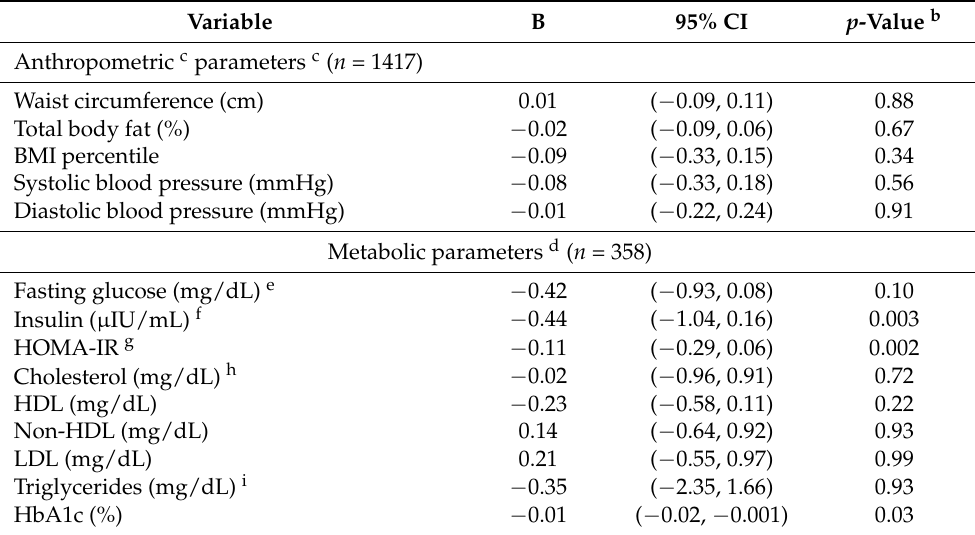
a All values represent mean ± SD. b Significance set at p < 0.05. c Regression models for anthropometric outcomes adjusted for age, sex, race and ethnicity, free/reduced-price school meal participation, school site, breakfast location, physical activity, baseline measure, and BMI z-score (for blood pressure models only). d Regression models for metabolic parameters adjusted for age, sex, race and ethnicity, free/reduced-price school meal participation status, school site, breakfast location, physical activity, baseline measure, and BMI z-score. e To convert mg/dL glucose to mmol/L, multiply mg/dL by 0.0555. f To convert µ IU/mL insulin to pmol/L,